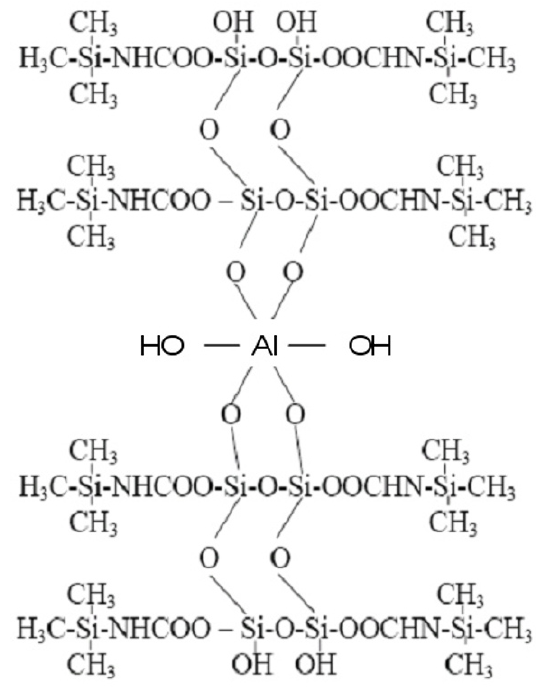
Figure 3. Structure of the silica-based hybrid material